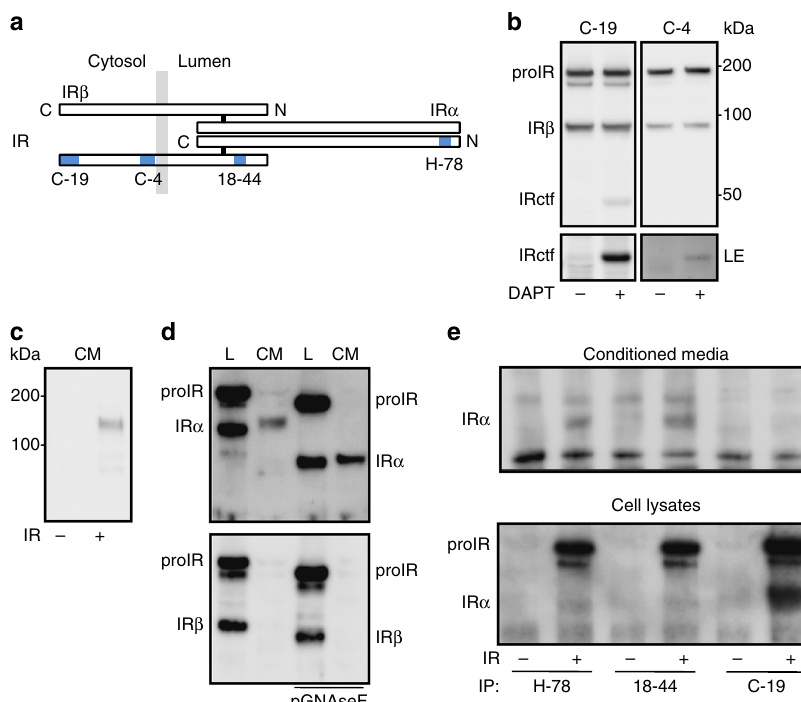
Fig. 1 Detection and characterization of IR fragments. a Schematic representation of IR showing the position of the peptides used as antigens to produce antibodies C-19, C-4, H-78, and that of the epitope recognized by antibody 18-44 (blue rectangles). N and C-terminal extremities and α and β subunits are localized. The membrane is represented by the light gray rectangles. b HEK 293 cells were transfected with IR expression vector and treated overnight with the γ -secretase inhibitor (DAPT; 5 μ M). IR was detected by immunoblot, using the indicated IR β -subunit (IR β ) speci fi c antibodies (LE indicates a long exposure of the immunoblot). Positions of IR precursor (proIR), IR β , and C-terminal fragment of IR (IRctf) are indicated. c Immunoblot analysis using the H-78 antibody of 24 h serum-free conditioned media (CM) from cells transfected with an empty plasmid ( − ) or with a plasmid encoding human IR ( + ). d Lysates (L) and CM from IR overexpressing cells were collected and where indicated in vitro, deglycosylated by PGNaseF. IR was detected by immunoblot, using H-78 antibody (upper panel) or C-19 antibody (lower panel). e CM and cell lysates from IR overexpressing cells ( + ) or cells transfected with an empty plasmid ( − ) were collected and subjected to immunoprecipitation (IP), using the indicated antibodies. IR was detected by immunoblot using H-78 antibody. IR α indicates the position of IR α